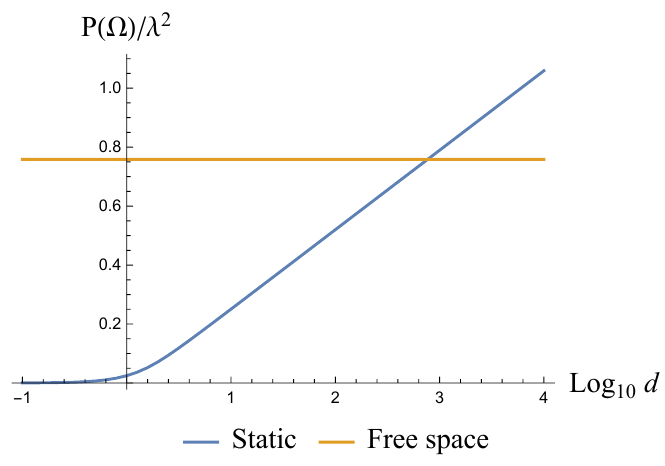
Figure 8 . Transition probability for Gaussian switching (cid:27) = 1 and (cid:10) = 1 ((cid:10) (cid:27) = 1) in (1 + 1) dimensions. Near the mirror P ((cid:10)) still decays quickly, but far from the mirror the contribution from the image term dominates and will exceed the free space case for any choice of IR cuto(cid:11) (cid:3). in eq. (A.4) can be re-expressed as total probability per unit time P ((cid:10)) =(cid:27) and in the limit (cid:27) ! 1 we